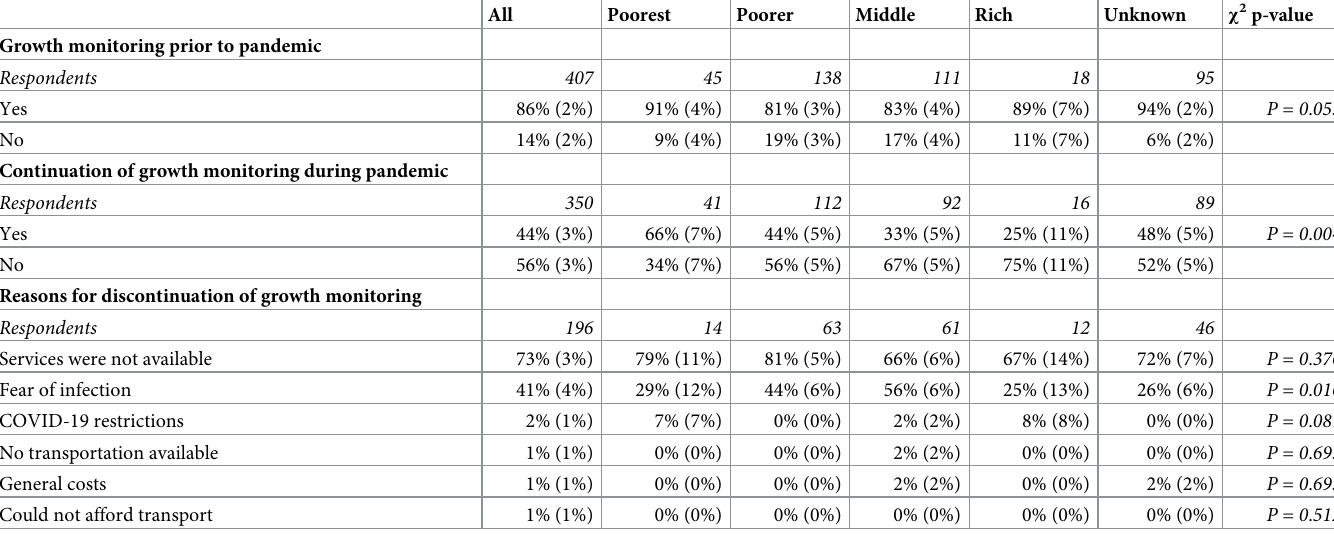
Table 5. Discontinuation of growth monitoring services and